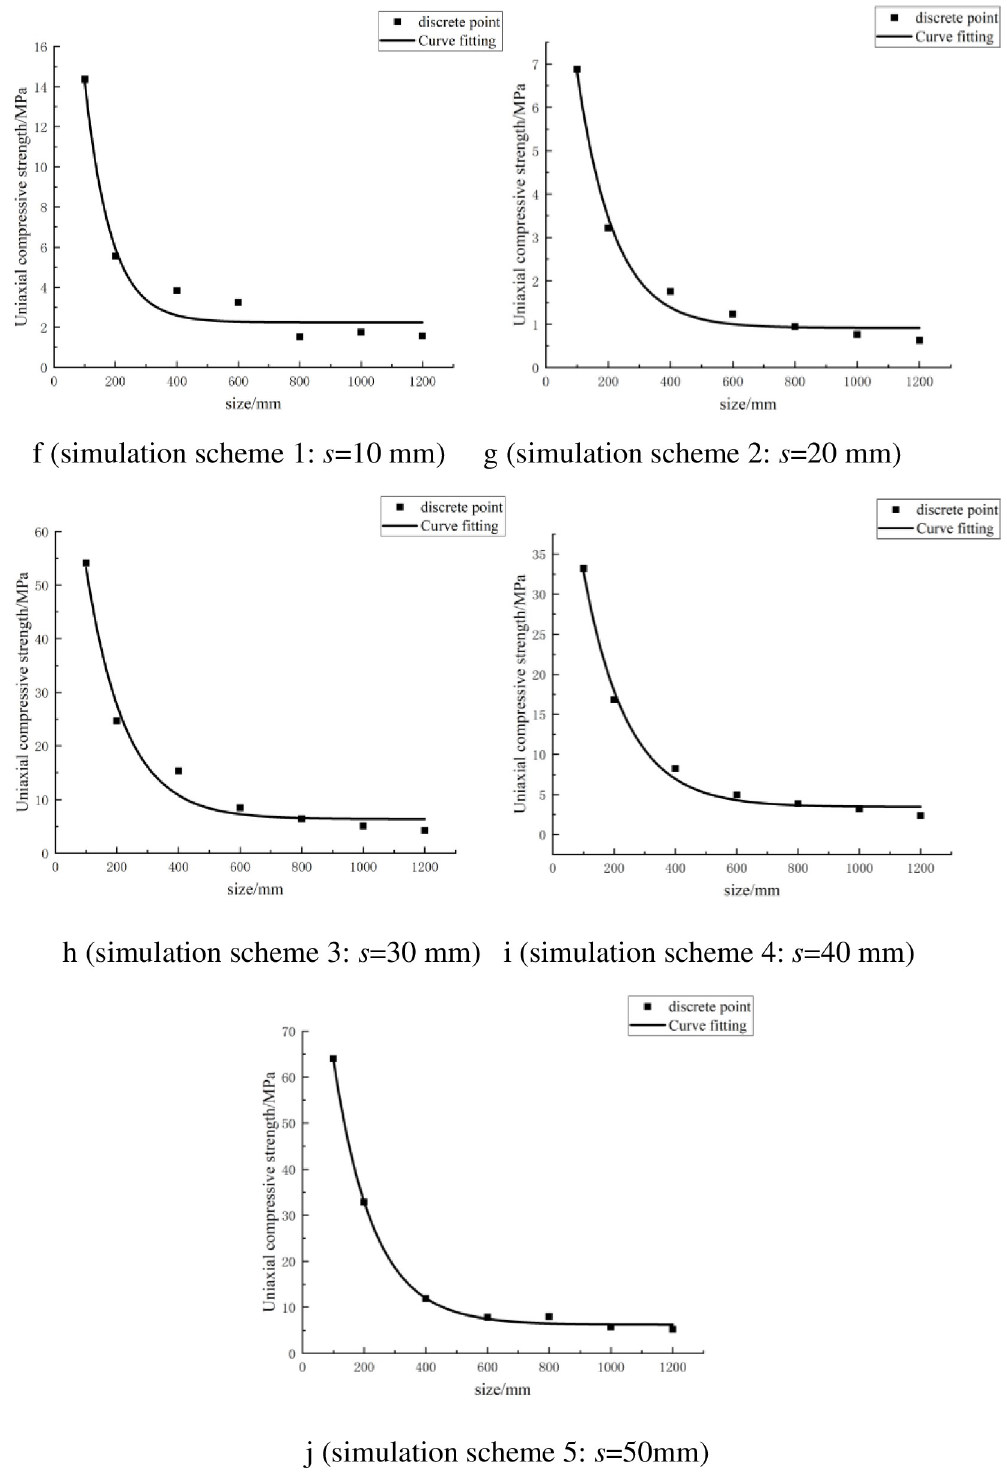
Fig 6. Fitting curve of uniaxial compressive strength and size of rock with parallel joints.